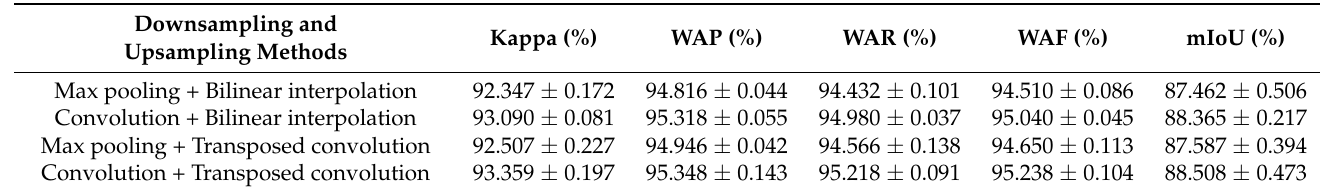
Table 6. Comparison of segmentation performance of the model with different downsampling and upsampling